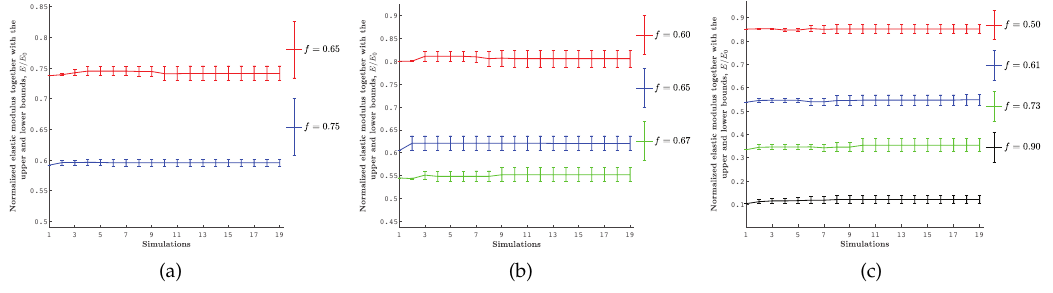
Figure 13. Convergence analysis of the numerical prediction of the three materials, ( a ) porous titanium, ( b ) porous CoCrMo alloy and ( c ) porous